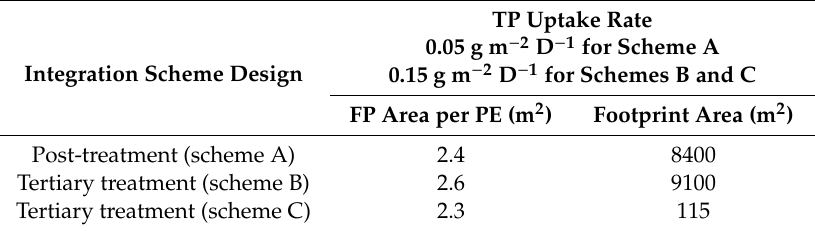
Table 3. Calculated design parameters of a biofilm system for P removal based on a geotextile cultivation area. The design of the system assumes several modules with a vertical geotextile arrangement (90 ◦ inclination angle). PE = person equivalent, FP Area = footprint area.